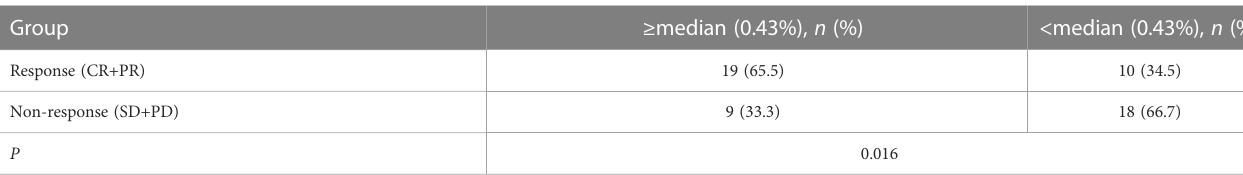
TABLE 6 Association between the abundance of EGFR T790M (median) and the curative effect of the third generation of EGFR tyrosine kinase inhibitors.